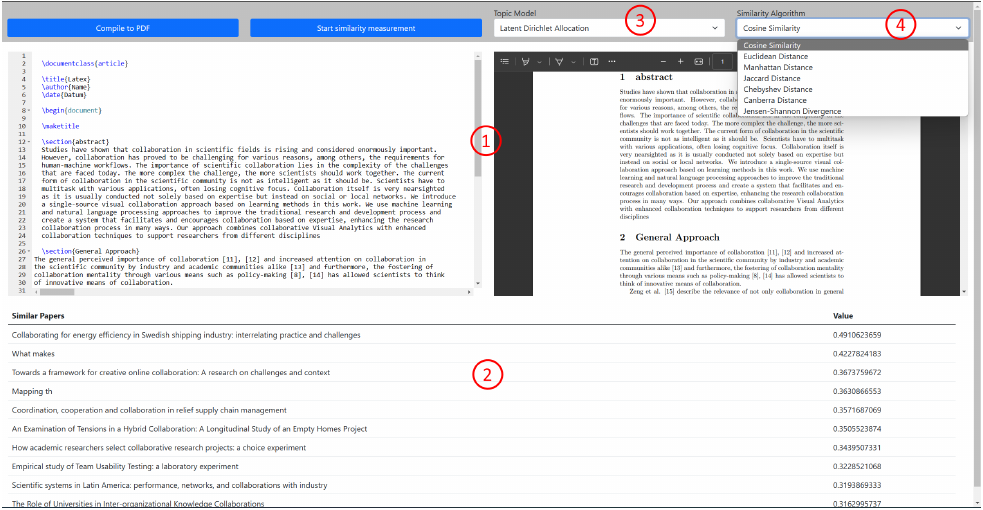
Figure 3. The latex editor user interface (UI) with recommendations. (1) shows the commonly known writing area with a PDF viewer. (2) shows the results. The titles are clickable, and the similarity score is shown. Furthermore, the researchers can choose their desired topic modeling approach (3) and similarity algorithm (4) via dropdowns.